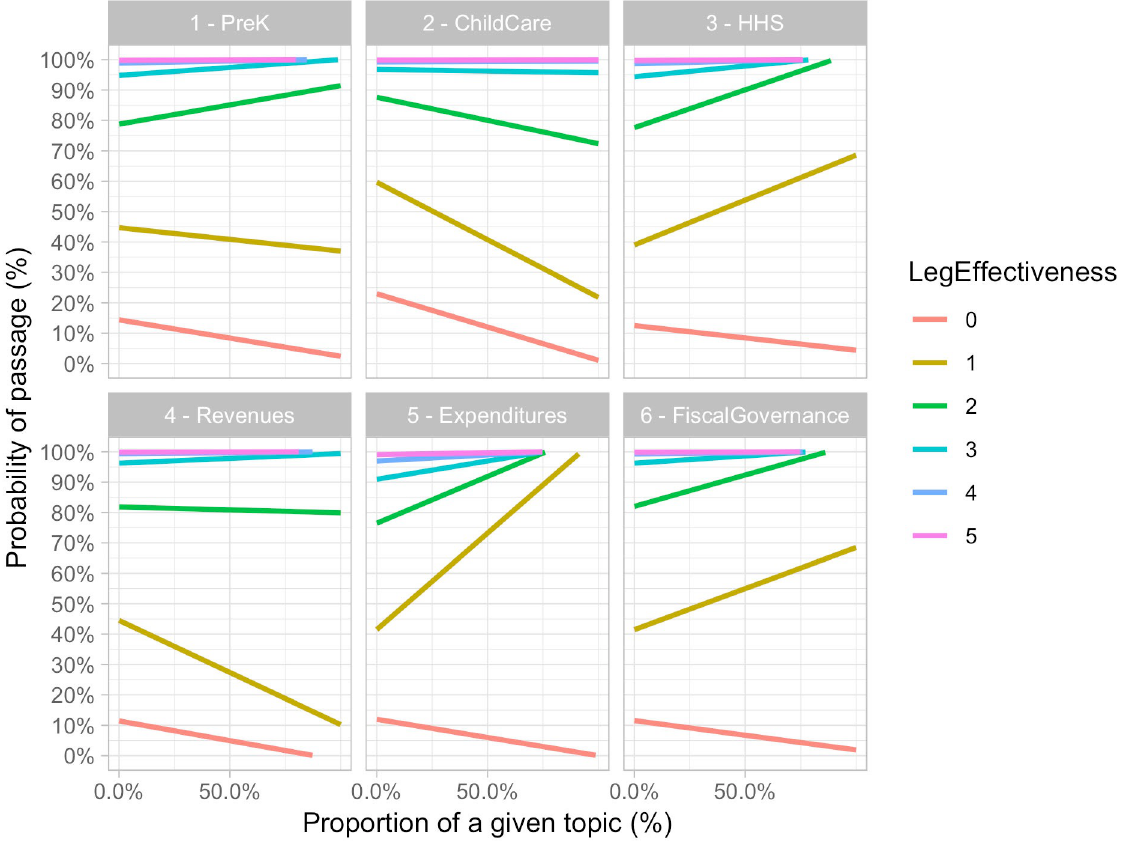
Fig 8. Moderating effect of legislative effectiveness on the association between the proportional coverage of a policy priority and the probability of bill passage.